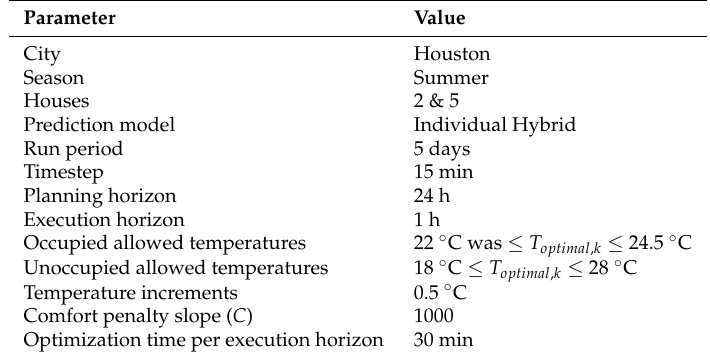
Table 11. Settings used for Model Predictive Control (MPC) optimization in Case 1.